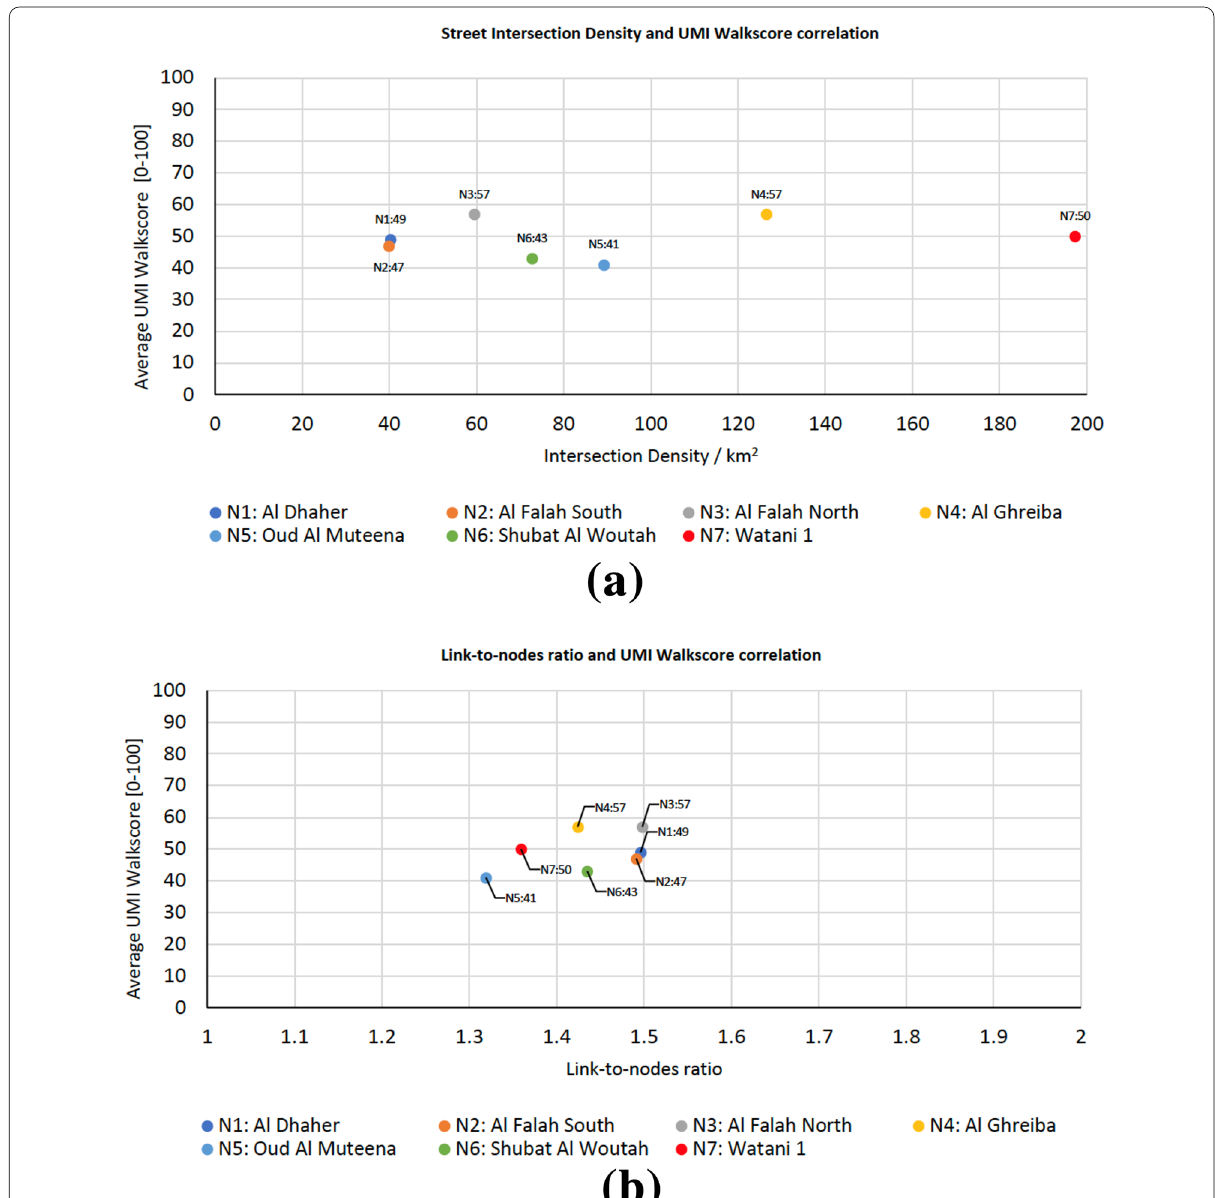
Fig. 9 Correlation results between the average UMI Walkscore and a Street intersection density, b Link-to-nodes